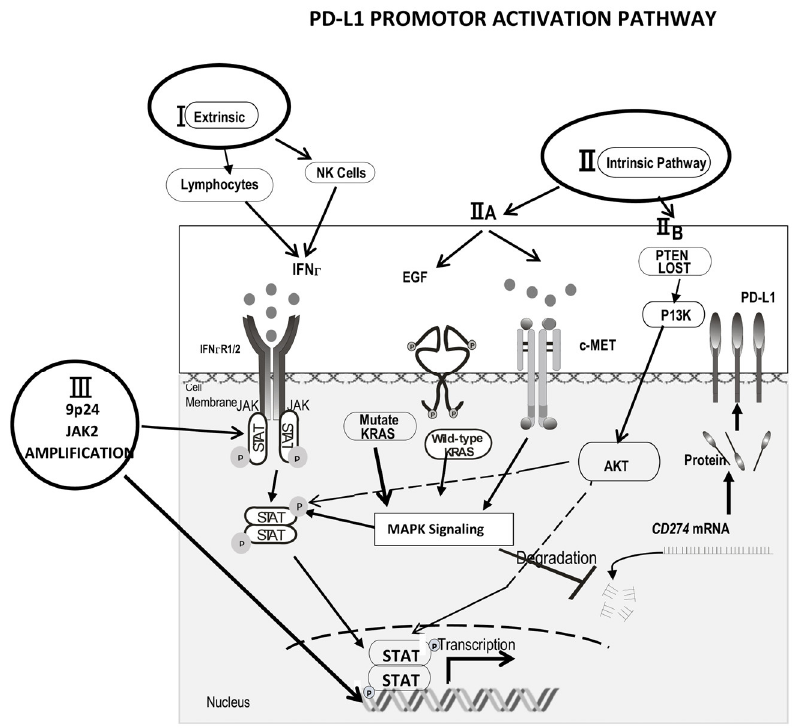
Figure 1. Proposed model for the three major mechanisms of PD-L1 activation. (1) The extrinsic mechanism: tumor-infiltrating lymphocytes (TIL) and NK cells produce IFN- γ . Then, IFN- γ